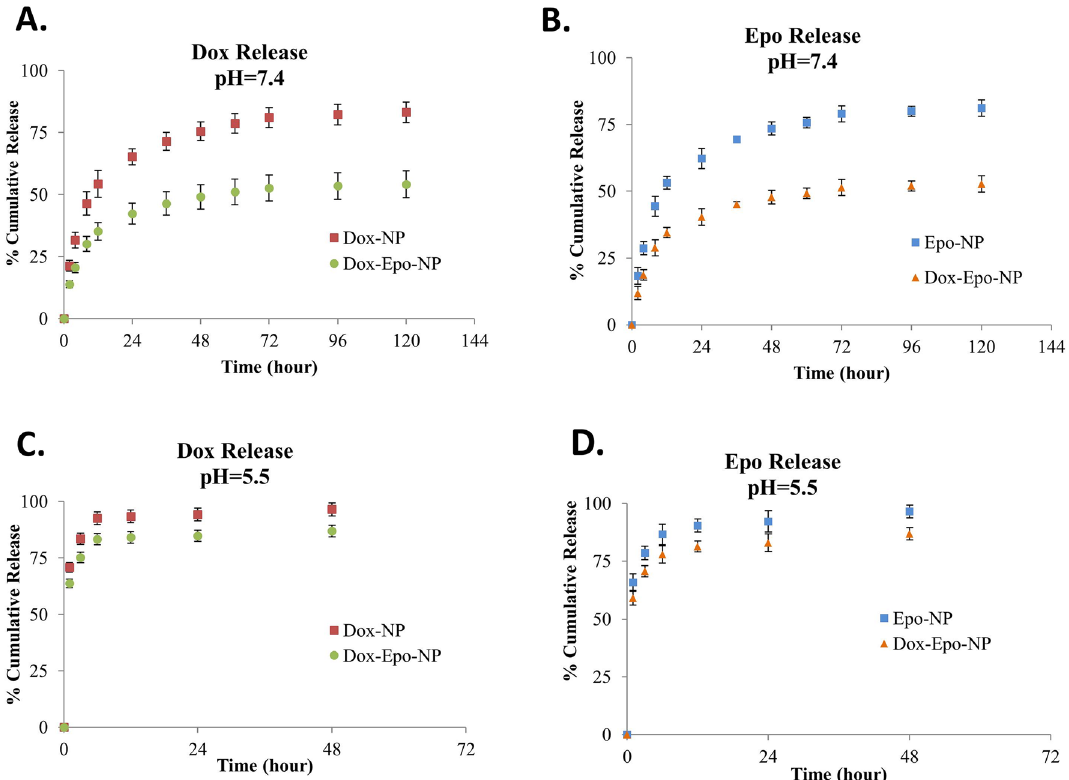
Figure 4. (A) Cumulative release of Dox versus time from two different Dox + Epo-NPs (circle) and Dox-NPs (square) at pH 7.4; ( B) Cumulative release of Epo versus time from two different Dox + Epo-NPs (triangle) and Epo-NPs (square) at pH 7.4; ( C) Cumulative release of Dox versus time from two different Dox + Epo- NPs (circle) and Dox-NPs (square) at pH 5.5; ( D) Cumulative release of Epo versus time from two different Dox + Epo-NPs (triangle) and Epo-NPs (square) at pH 5.5. Groups